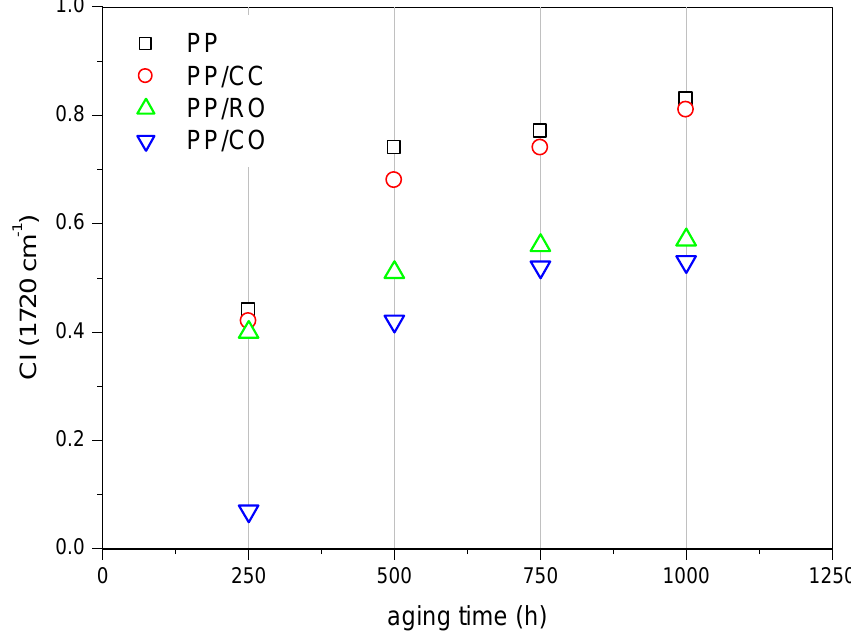
Figure 5. The changes in carbonyl index of iPP and its composites after accelerated aging.